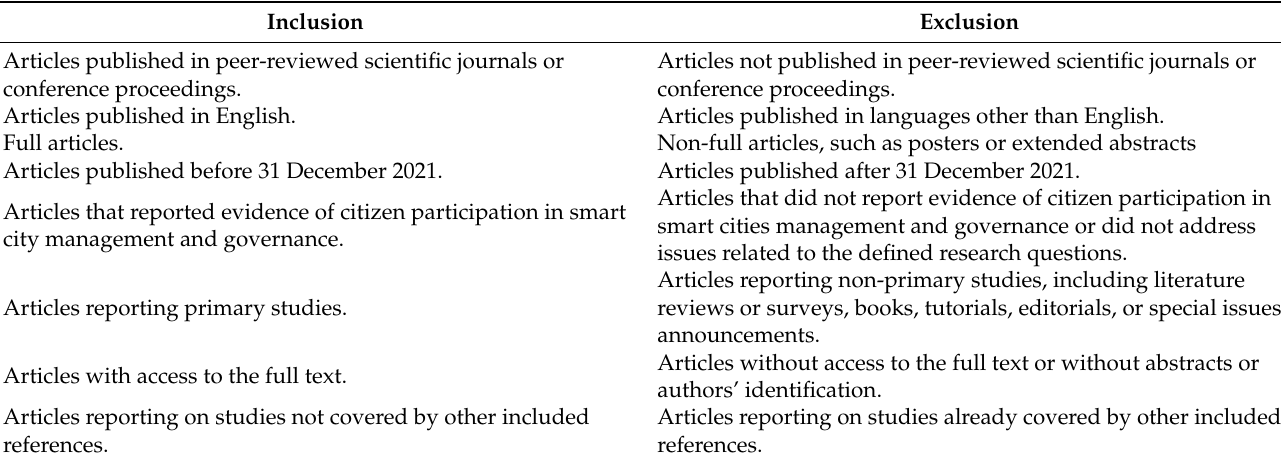
Table 1. Inclusion and exclusion